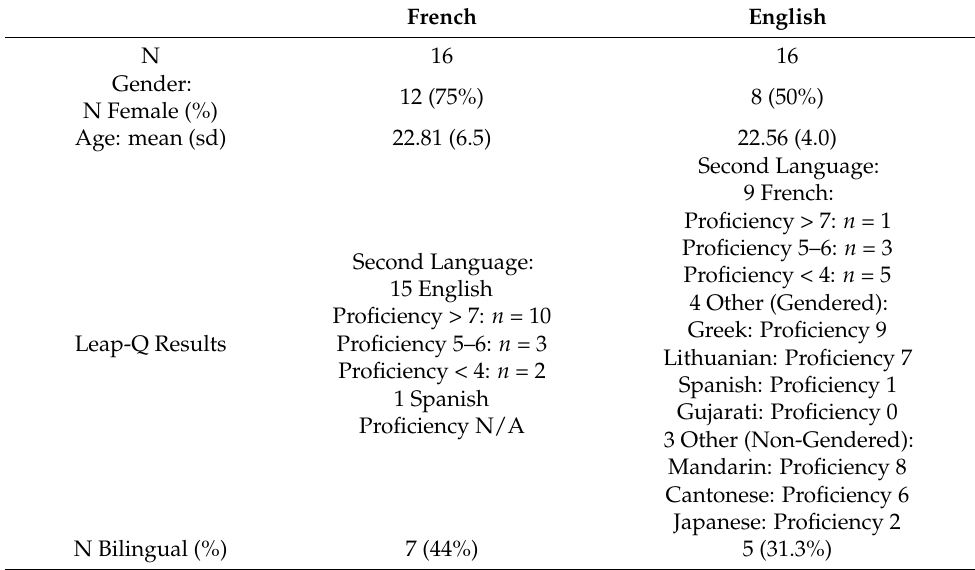
Table 1. Summary of Participant Group Characteristics.